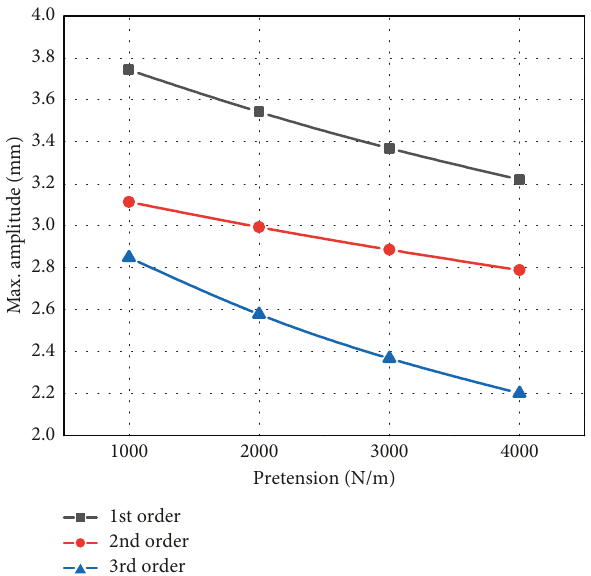
Figure 5: First three-order max. amplitude under different pre- tension levels when arch-to-span ratio is 1/10 and hailstone di- ameter is 5.0cm.